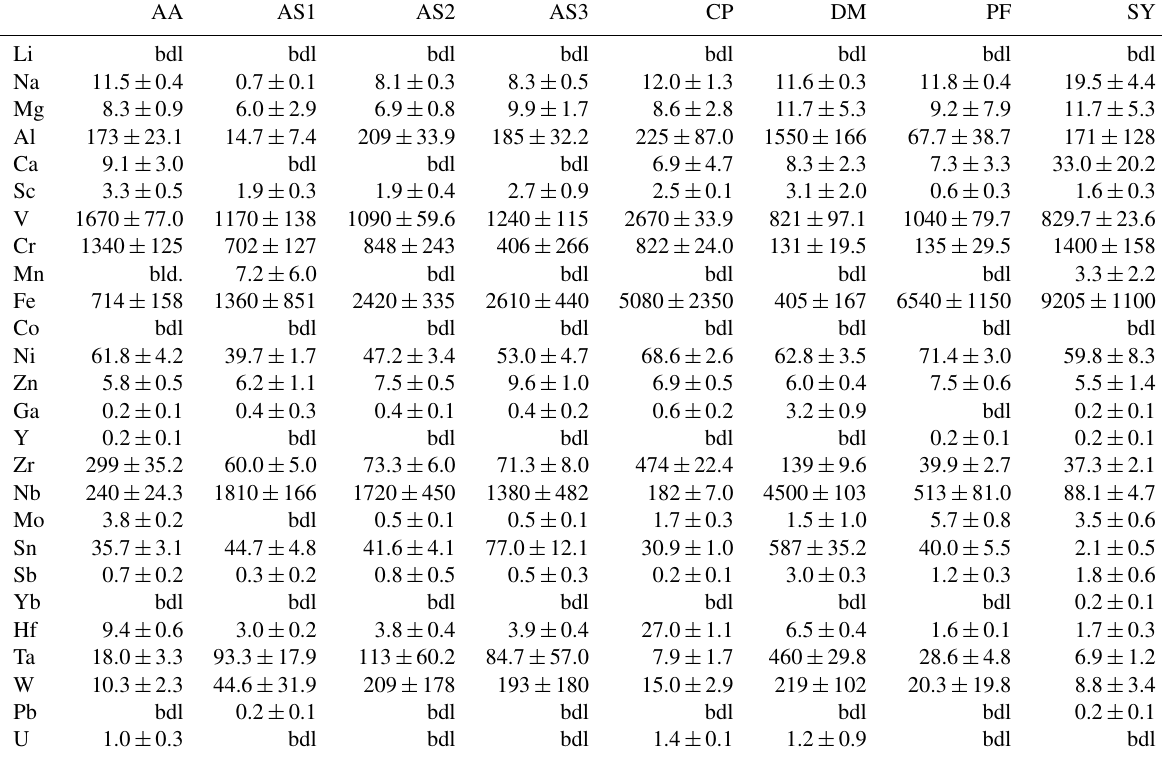
Table A1. Complete data set of rutile trace-element compositional data, measured by LA–ICP–MS, values given in µgg − 1 with 2 σ errors. bdl – below detection